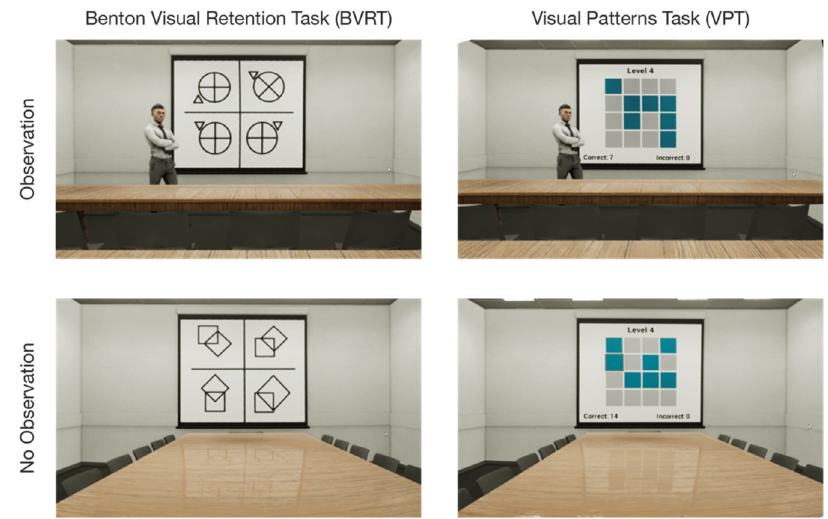
Figure 1. The study observation conditions (observation vs. no observation) with Benton visual retention task (BVRT) and visual patterns task (VPT). Observation was operationalized with the addition of a static human avatar at the front of the room.